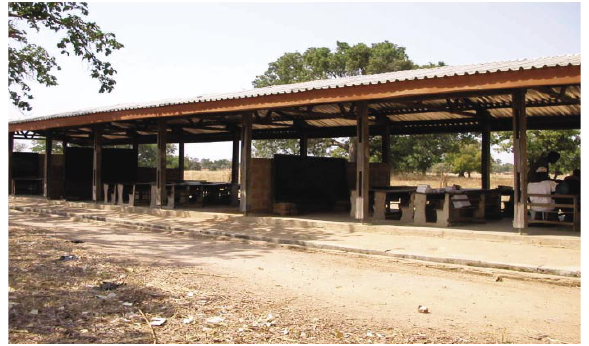
Figure 10 . A typical classroom in the rural village where formal school is held during the day and non-formal in the evenings.